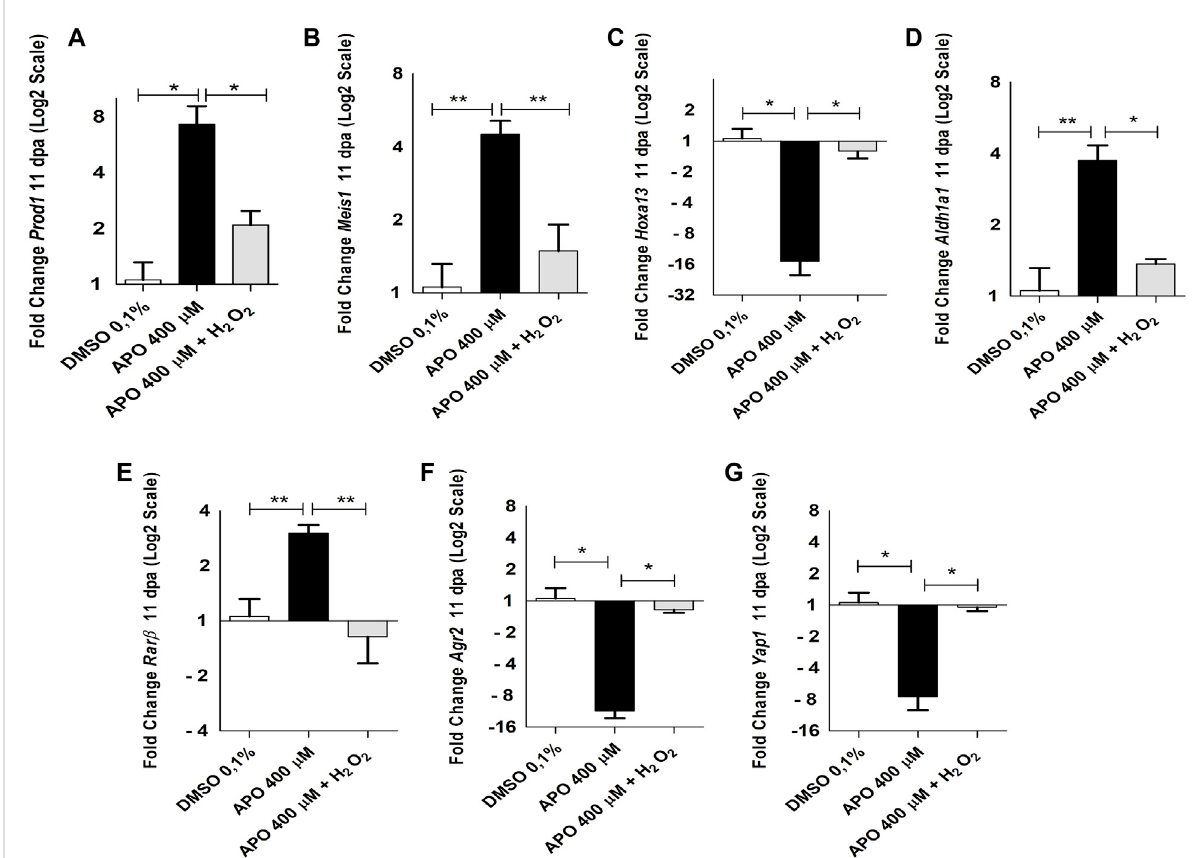
FIGURE 7 NOXs-dependent production ROS inhibition and exogenous H 2 O 2 induces expression changes of genes related to blastema formation and positionalidentityduringlimbregenerationin A.mexicanum at11dpa. (A – G) ,RT-qPCRof Prod1,Meis1,Hoxa13,Aldh1a1, Rar β ,Agr2 and Yap1 genes. The results show that blocking ROS production signi fi cantly affects the expression of the genes described here and their expression levels can be rescued by the application of exogenous H 2 O 2 . Gene expression levels were normalized to the expression of the endogenous reference gene 18S . Data are expressed as mean ± SEM. One-way ANOVA followed by Tukey ’ s post hoc test was performed for comparisons between groups treated with apocynin, exogenous H 2 O 2 and controls in 0.1% DMSO. *** p < 0.001, ** p < 0.01, * p <